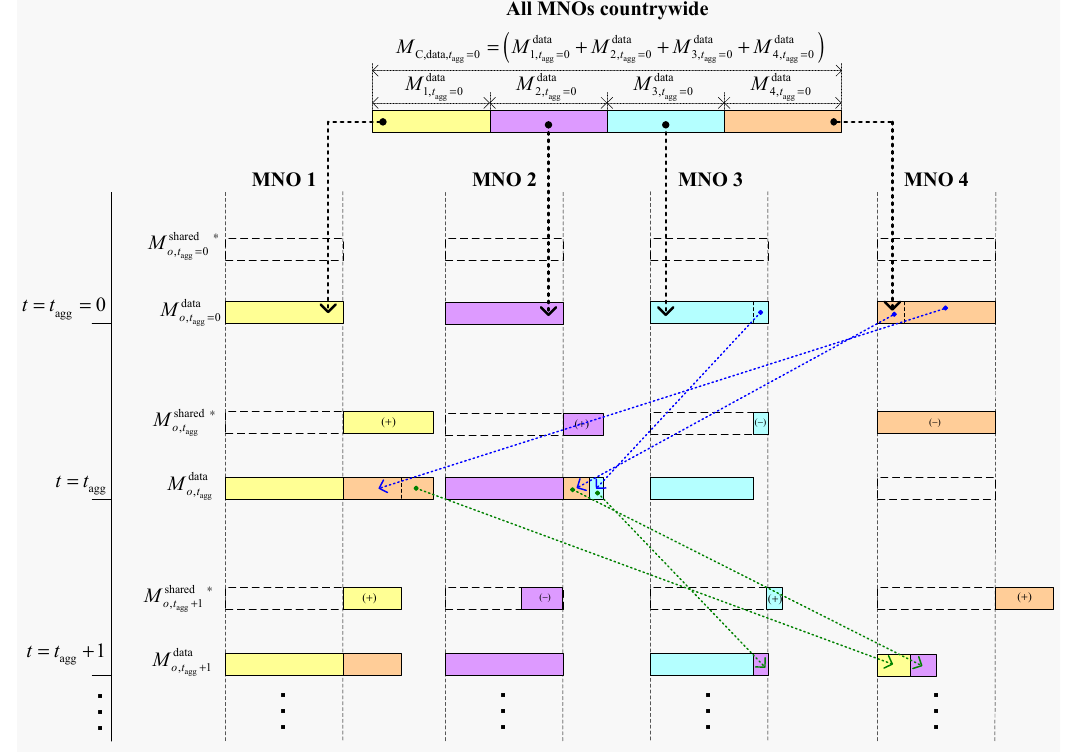
Figure 8. An illustration of the application of DESA to an arbitrary country of four MNOs for 5G services with the 28 GHz mmWave spectrum.